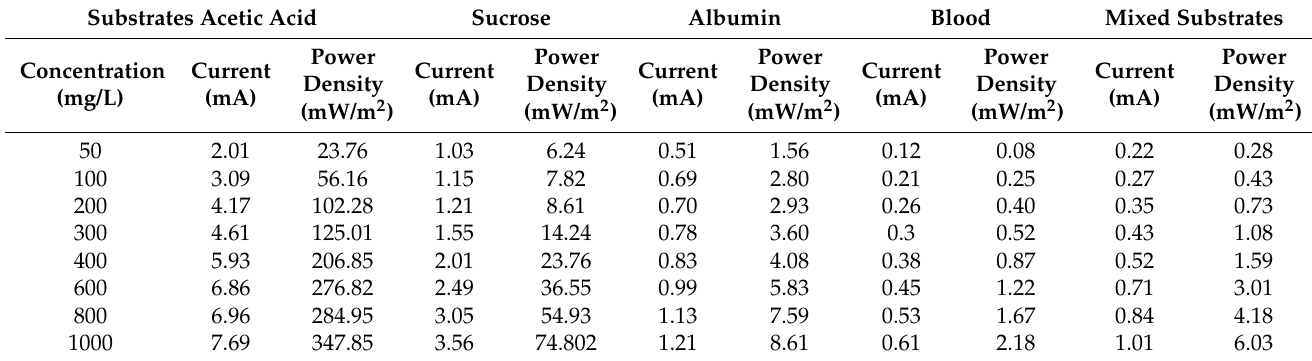
Table 1. Current and power density observed at various substrate concentrations treated in the anaerobic